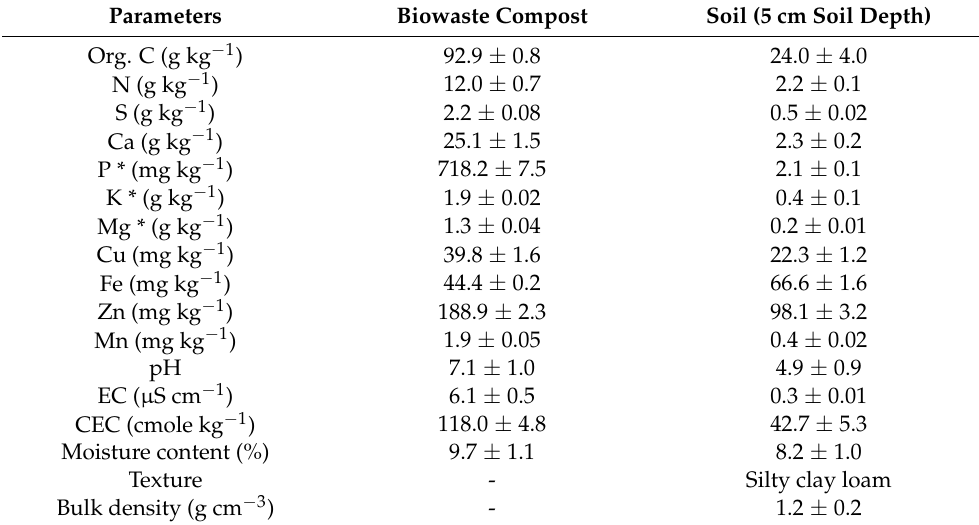
Table 1. Properties of soil and compost used for the incubation experiment (N = 4, Mean ± stan- dard